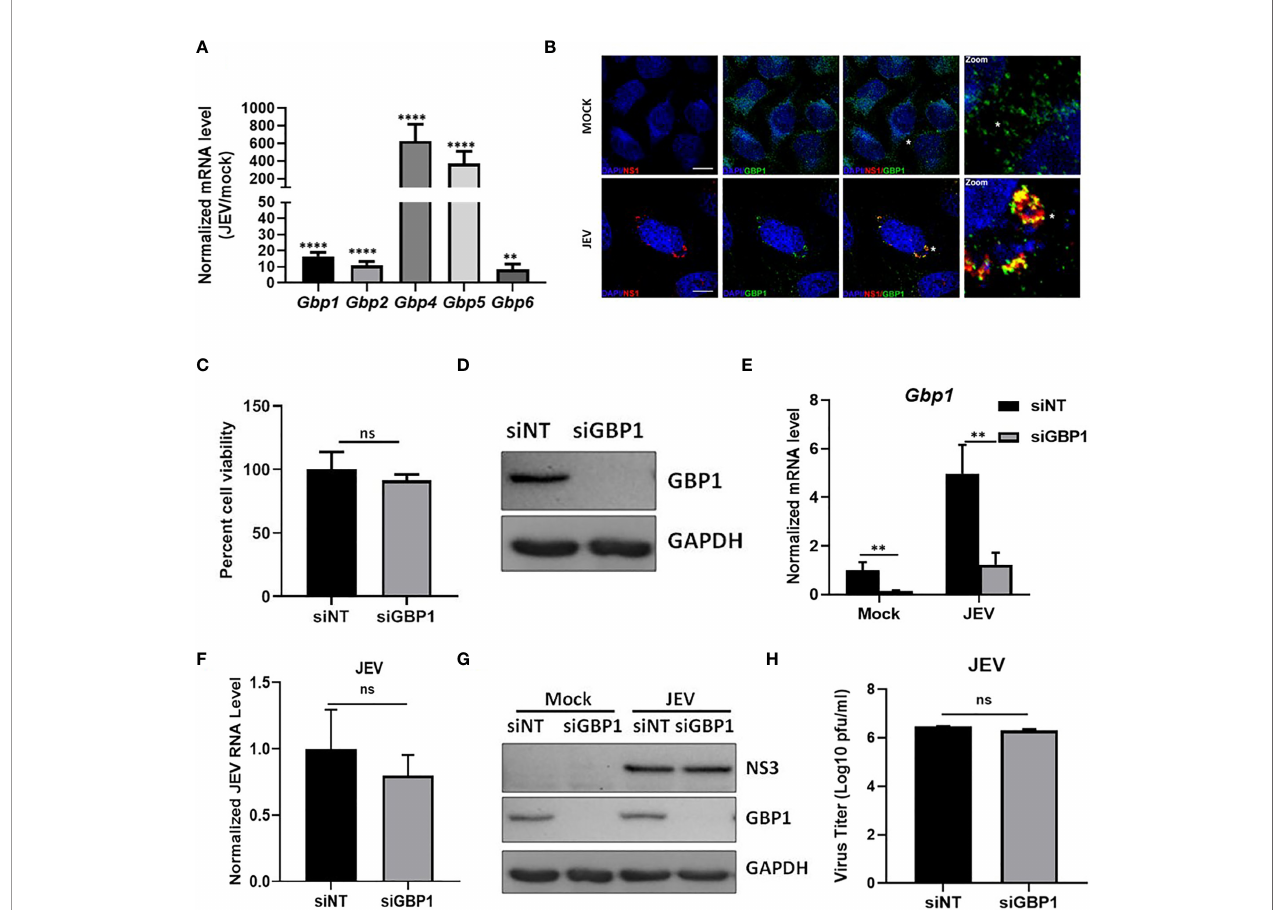
FIGURE 1 | GBP1 depletion does not affect JEV replication in an IFN g unprimed environment. (A) HeLa cells were mock/JEV infected (1 MOI) for 24 h, and mRNA levels of Gbps were quanti fi ed by qRT-PCR. Graph shows the relative expression level of gene transcripts in mock/JEV infected samples. (B) Mock/JEV-infected (3MOI) HeLa cells were fi xed at 24 hpi and immunostained for GBP1 and JEV NS1. Images were acquired on a confocal microscope using a ×60 objective. Scale bar 10µm. (C) Western blot showing depletion of GBP1 in siRNA treated HeLa cells at 48 hpt. (D) HeLa cells transfected with NT/GBP1 siRNA for 48 h, were mock/ JEV infected (1 MOI, 24 h), and GBP1 mRNA levels were determined by qRT-PCR. (E) HeLa cells transfected with NT/GBP1 siRNA for 48 h, were either mock/JEV (5 MOI) infected. At 48 hpi, cell viability was determined by MTT assay. Data is shown normalized to NT-siRNA transfected mock treated cells. (F – H) HeLa cells transfected with NT/GBP1 siRNA for 48 h, were either mock-or JEV infected (1 MOI, 24 h), and JEV RNA levels were determined by qRT-PCR (F) , cell lysates were analyzed by western blotting with JEV-NS3, GBP1 and GAPDH (loading control) antibodies (G) , and virus titer was quantitated by plaque assays (H) . Western blots are representative of three or more independent experiments. Data presented is mean ± SD of values obtained from 3 independent experiments. Student t -test was used to calculate P values. ** P < 0.01, **** P < 0.0001. ns, Non signi fi